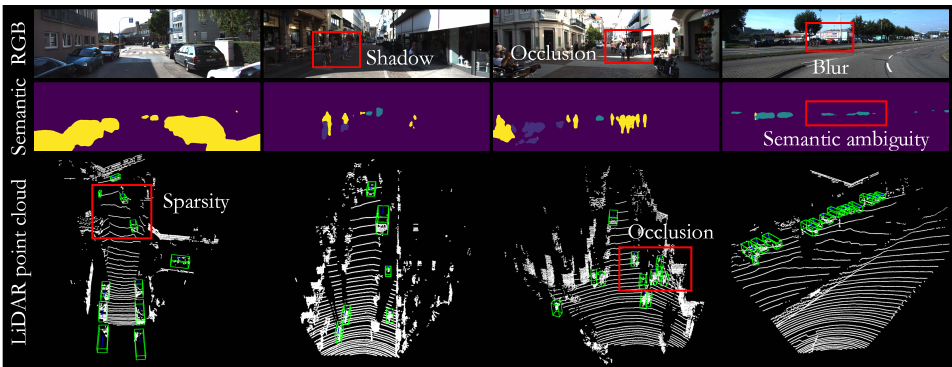
Figure 6. Multi-sensor data collected by the LiDAR-camera system in the different outdoor scenarios. Occlusion, shadow, blur, and sparsity in the LiDAR point cloud and RGB image have impacts on the detection difficulty and annotation accuracy (only for pseudo label) of the 3D object, limiting the efficiency of SSOD-3D. Blur in RGB images causes ambiguity in the semantic image. The image and 3D point cloud show significant differences in the various scenes. 3D objects are detected using the proposed PSPSL-3D framework with R anno =